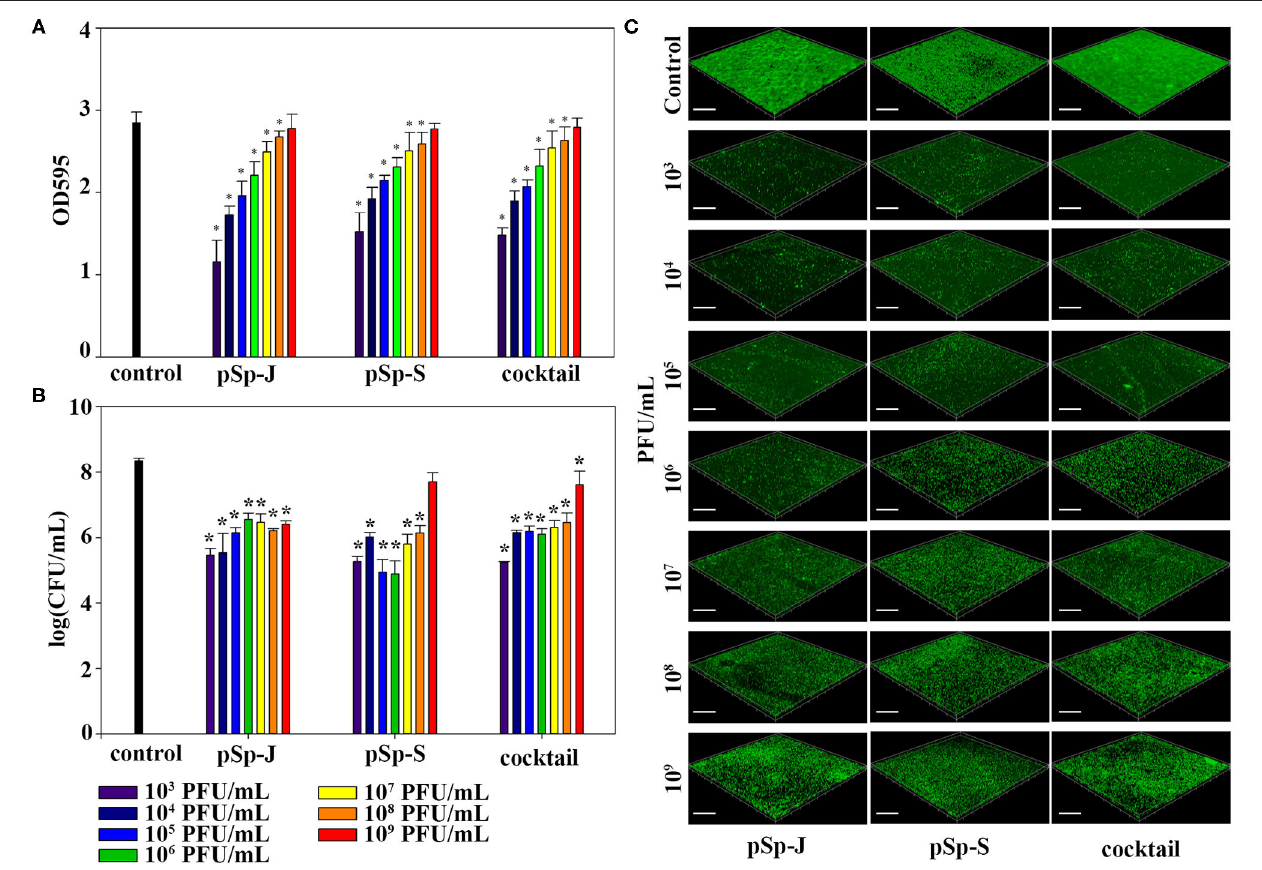
FIGURE 5 | The endpoint reaction measurement for biofilm prevention by pSp-J, pSp-S, and the phage cocktail. (A) The total biomass of the biofilm was stained with crystal violet and the optical density (OD) at 595nm was measured. (B) Viable bacterial cell count in the biofilm was measured by the standard plate count and (C) visualized with a confocal laser scanning microscope. Scale bar = 100 µ m. Values are presented as the mean ± standard deviation; a one-way ANOVA (Bonferroni post-hoc test) was performed to determine statistically significant differences ( P < 0.05) between groups. Asterisk indicates statistical significance between the experimental and control